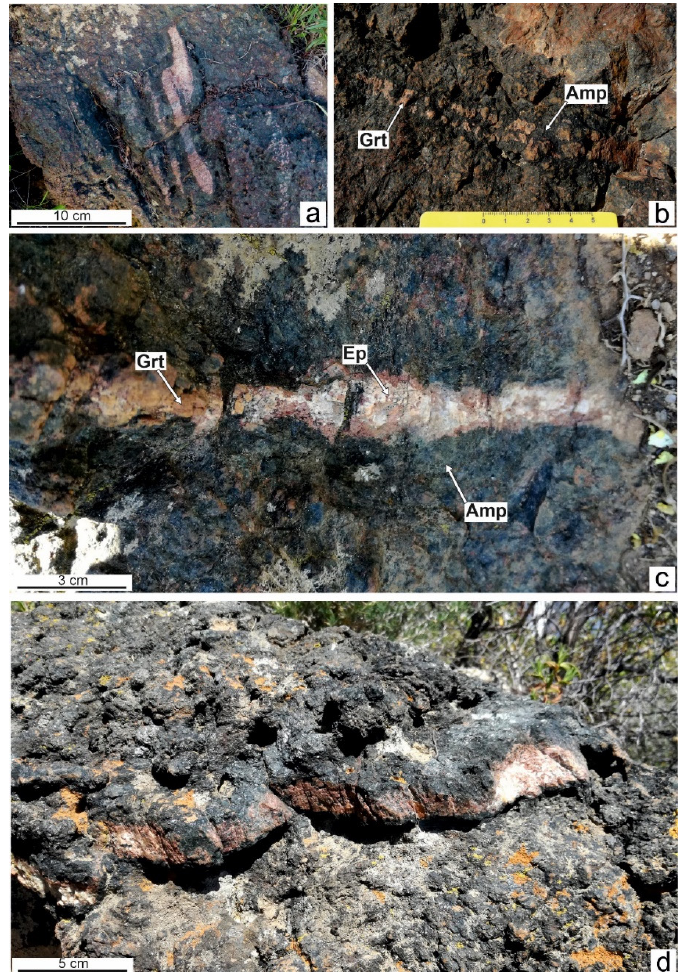
Figure 2. Field photographs of different garnet veins in Layer C of ultrabasic amphibolites from Golfo Aranci area: ( a ) Decimeter-sized garnet veins subparallel to S2; sample MN50; ( b ) Garnet vein with amphibole rim; ( c ) Garnet vein with epidote in its central part, surrounded by an amphibole rim; from the wall-rock to the vein center, a clear, symmetric mineralogical sequence is observed; ( d ) Garnet-rich vein near to the top of Mt. Nieddu with epidote; sample MN21V. Grt = garnet; Amp = amphibole; Ep =